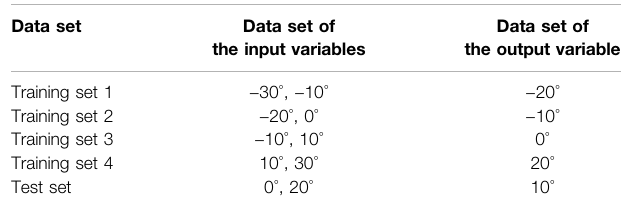
TABLE 6 | Construction of the training set and test